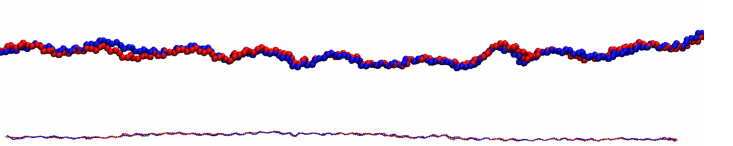
Figure A2. Chains A of the lowest DOPE model built with allhmodel (blue) and 3HR2 (red) are shown in VMD as VDW. Zoomed ( top ) and distant ( bottom ) views.